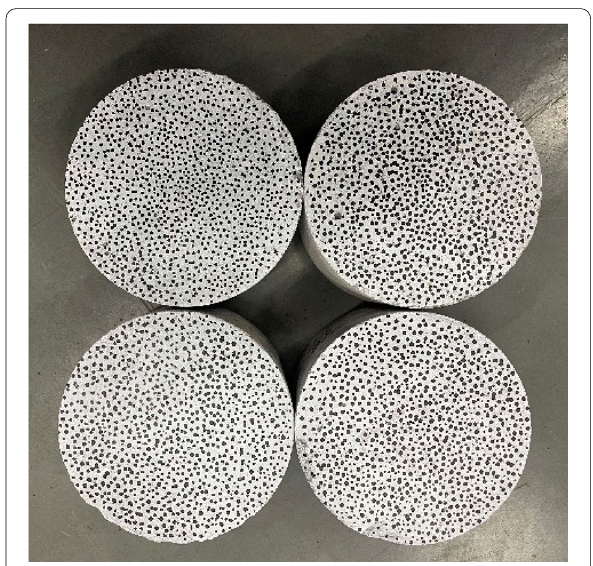
Fig. 3 Specimens for dynamic splitting